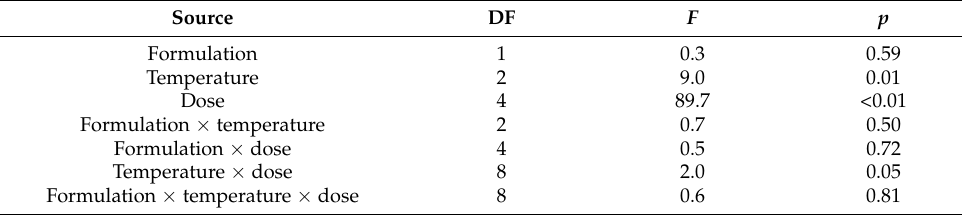
Table 4. ANOVA parameters for progeny production of Prostephanus truncatus (total DF =